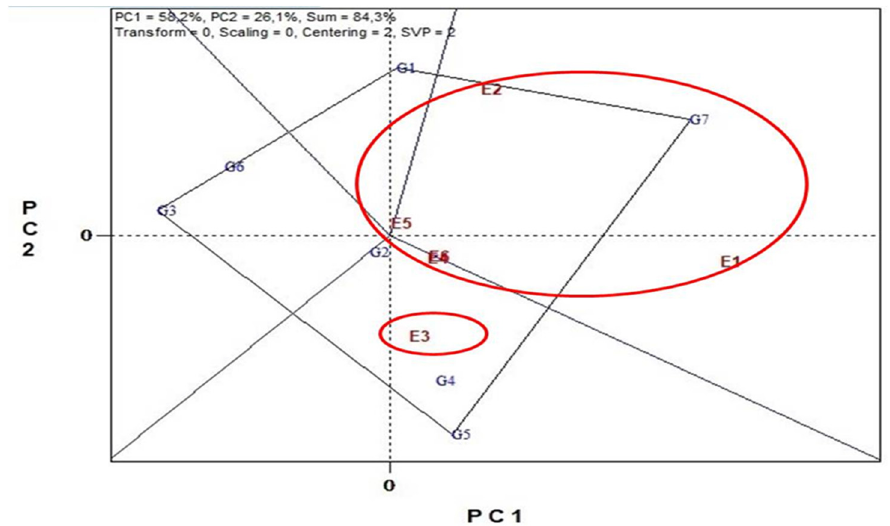
Figure 2. “Which-won-where or which is best for what” view of the GGE biplot based on biomass yield on seven V. sativa genotypes in six environments. Environment 4 and Environment 6 coincide.